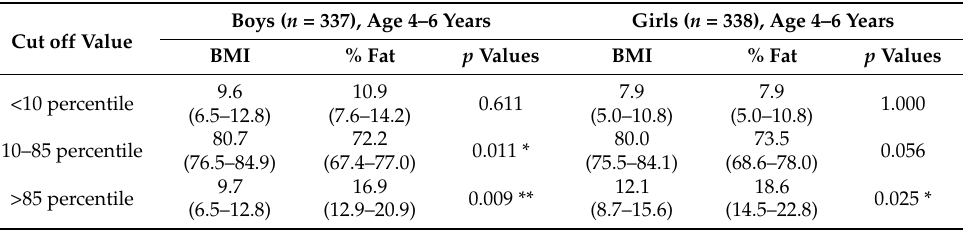
Table 3. The differences in the prevalence of low, normal, and overweight by Body Mass Index (BMI) and percent body fat ( χ 2